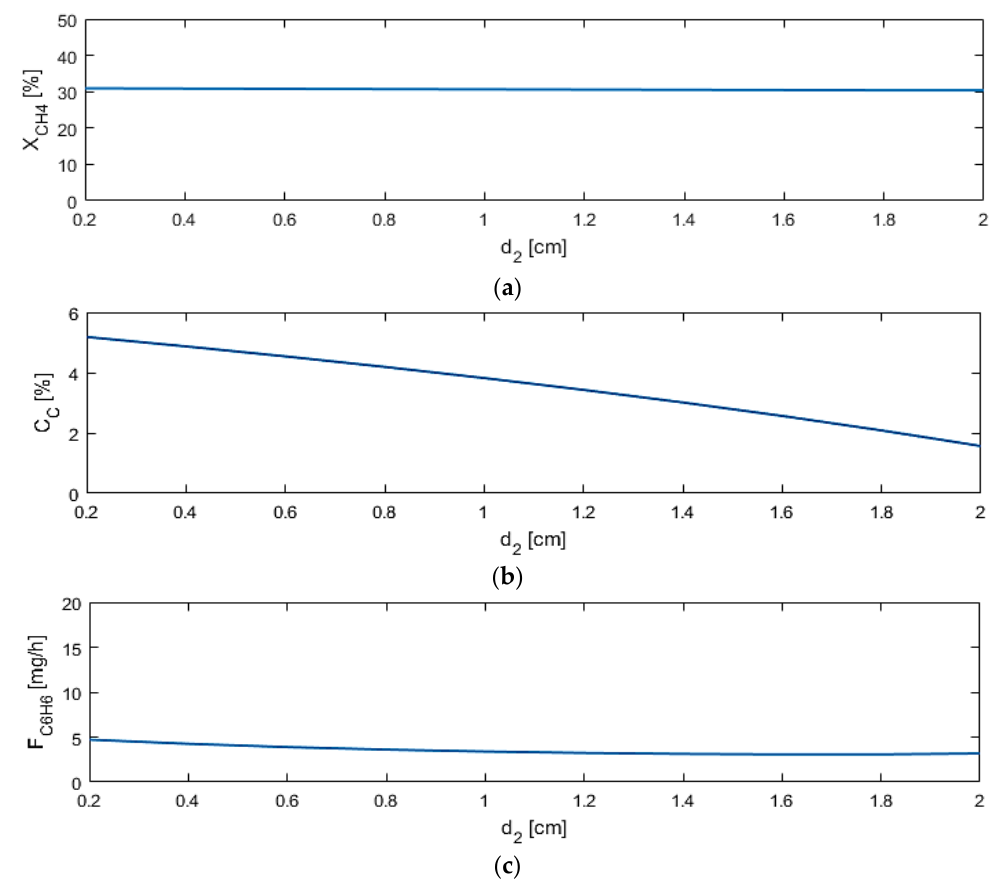
Figure 6. Sensitivity studies of d 2 for model performance criteria: ( a ) X CH4 ; ( b ) C C ; ( c ) F C6H6 .